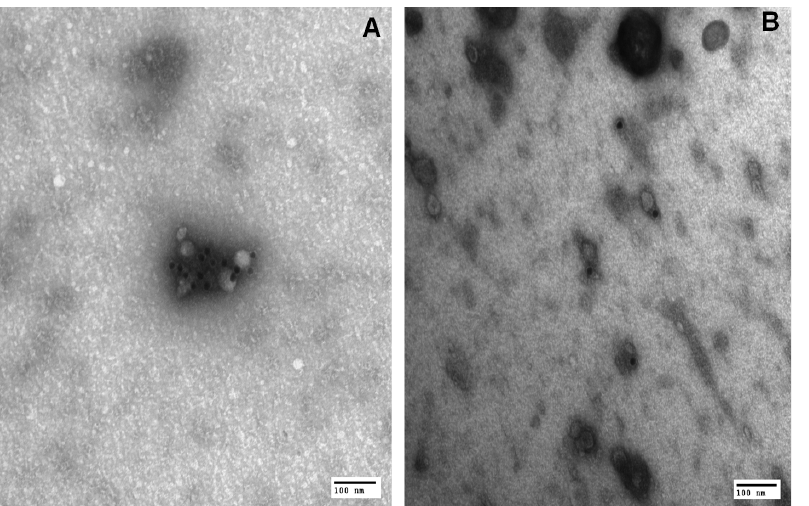
Figure 5. GGT localization on exosomes by transmission electron microscopy. Exosomes from A) plasma and B) bile were incubated with a primary antibody directed against GGT and with a secondary 15 nm gold particle-conjugated antibody. After fixation with glutaraldehyde, samples were negatively stained with uranyl acetate and examined under a transmission electron microscope.